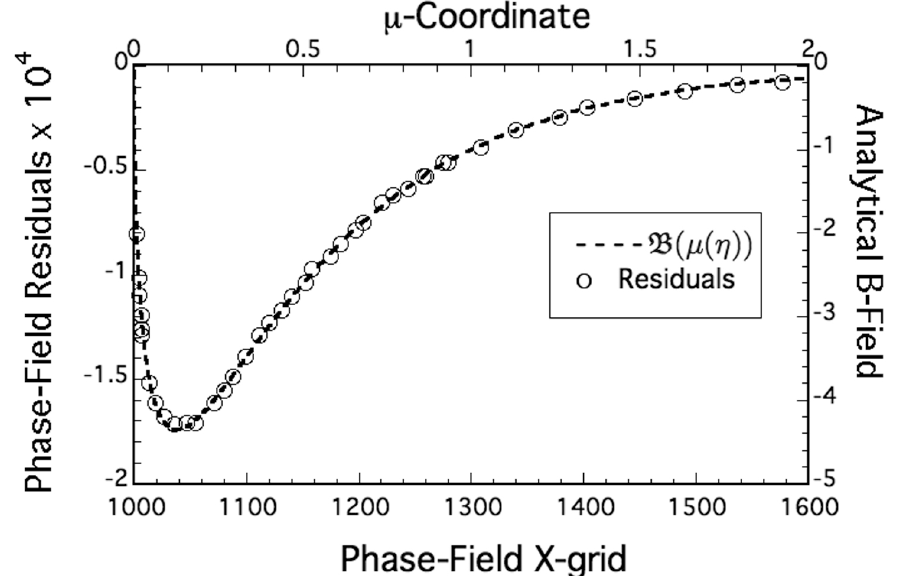
◦ Figure 6. Phase-field residual potential measurements ( -symbols) along the simulated right isoline of an equilibrated grain boundary groove with zero dihedral angle. Data points plotted with the bias field distribution, B ( µ ( η )) , for its counterpart variational groove profile. The scale-factor 300:1 was chosen between the phase-field’s abscissa, X-grid (minus 1000), and the dimensionless abscissa coordinate, µ . A fixed ratio, ξ = 2.50, applied to the left-ordinate is used here to compare simulated residuals ( × 10 4 ) with the corresponding right-ordinate B ( µ ( η )) -distribution. The ξ -value proportioning these simulation data was chosen as the ratio of the largest phase-field residual, − 1.740 × 10 − 4 , to the largest B -value, − 4.35. Residual measurements from phase-field simulation and the corresponding predicted distribution, B ( µ ( η )) , from sharp-interface theory represent independent estimates of capillary-mediated cooling perturbations along a stationary grain boundary